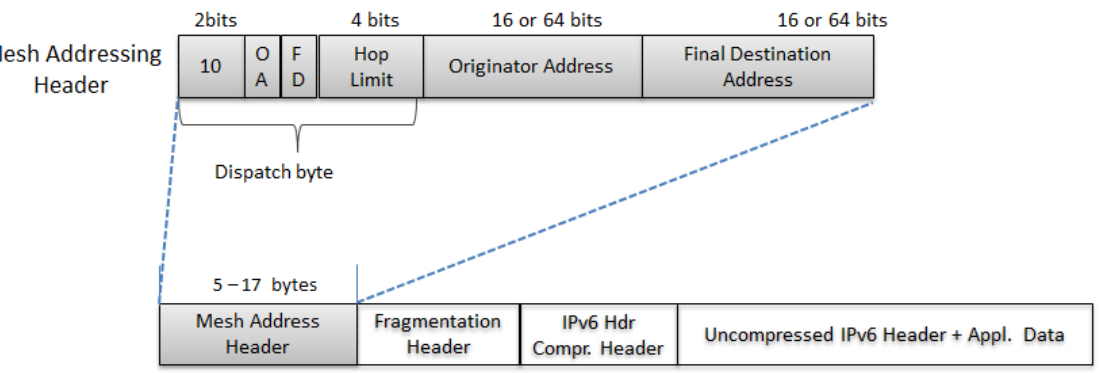
Figure 8. 6LoWPAN Mesh Addressing